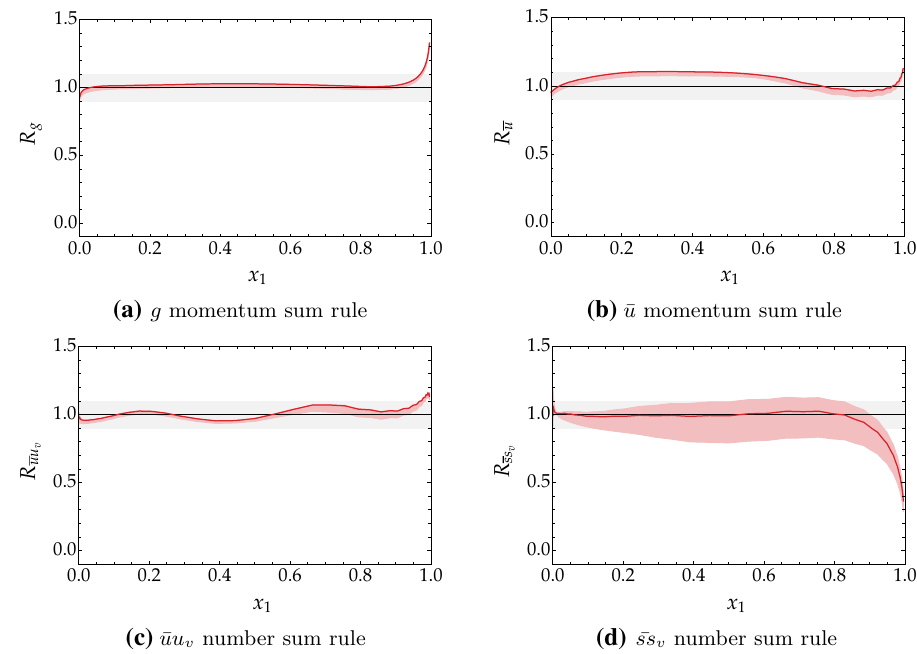
Fig. 17 Cutoff scale dependence of sum rule ratios, evaluated at μ = μ min for the final iteration of our model. The solid curve is for ν = μ , and the band corresponds to a variation of ν between μ/ 2 and 2 μ